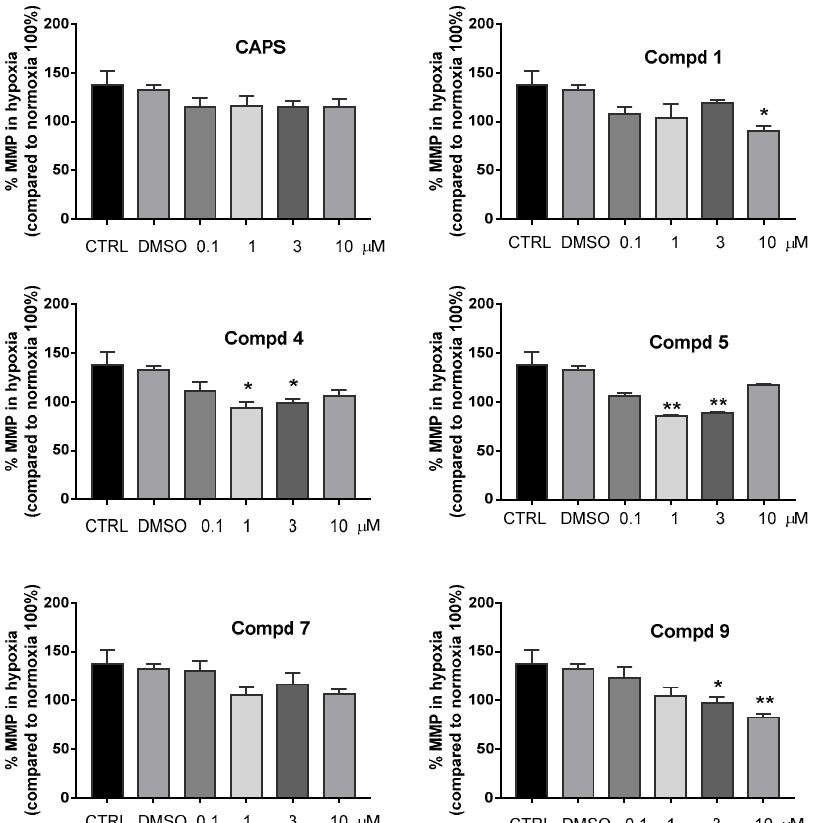
Figure 4. Modification of mitochondrial membrane potential (MMP), measured by loading HaCat cells with 6 µ M JC-1, after 48 h of hypoxia (2% O 2 , 5% CO 2 and 93% N 2 ) in the absence (CTRL) or presence of capsaicin or compounds 1 , 4 – 5 , 7 and 9 . Data are reported as percentage of MMP in hypoxia compared to the respective value in normoxia taken as 100%. The solvent of the compounds (dimethyl sulfoxide, DMSO) and the control did not show any significant difference. Each point represents the mean ± SEM of five independent experiments. (ANOVA and Bonferroni post hoc-test). * p < 0.01; ** p < 0.01 vs. CTRL.